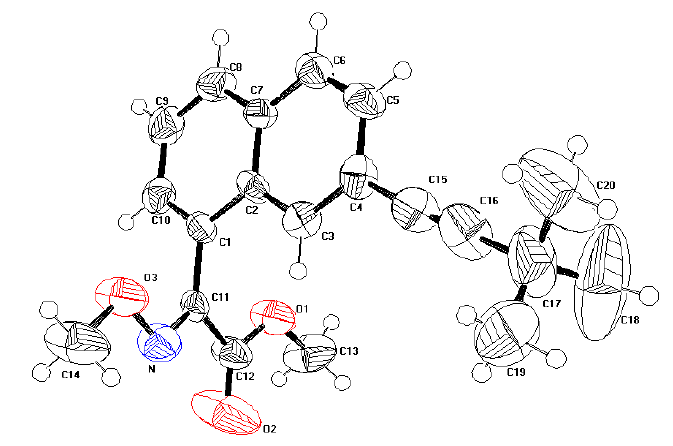
Figure 1. Perspective view of the molecule showing the atom-labelling scheme. Displacement ellipsoids are drawn at the 50% probability level and H atoms are shown as small spheres of arbitrary